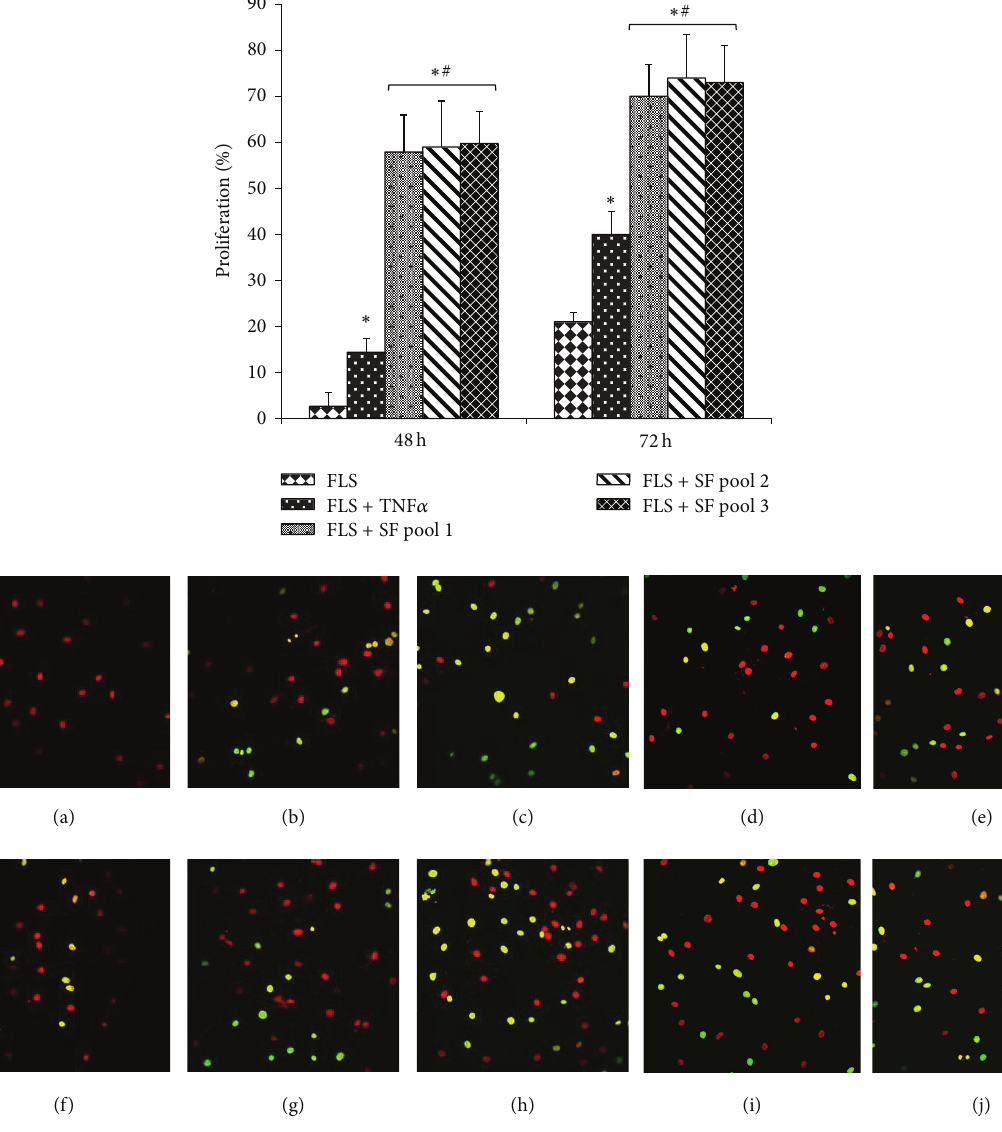
Figure 1: RA fibroblast-like synovial cells proliferation in the presence of synovial fluid or TNF 𝛼 . FLS were cultured in the presence of TNF 𝛼 (25 ng/mL) or three SF pools (1:8 dilution in culture medium). The DNA synthesis was evaluated after 24 h incubation with 10 𝜇 M 5-ethynyl- 2 󸀠 -deoxyuridine (EdU). Cells were then fixed and permeabilized, and EdU incorporated into newly synthesized DNA was detected using the fluorescent Alexa Fluor 488 azide. Analysis was performed using a confocal microscope. Data were obtained from triplicate experiments. Resultsareshownas%ofproliferation:%=(nucleistainedwithEdu/totalnuclei) × 100andrepresentfourindependentexperiments.Confocal microscopy images of a representative experiment are shown: cells cultured for 48h in alone medium (a), TNF 𝛼 (b), or SF pools (c, d, e), cells cultured for 72 h in medium alone (f), TNF 𝛼 (g), or SF pools (h, i, j). Green staining: newly synthesized DNA, red staining: Hoechst staining of total DNA. ∗ 𝑃 < 0.05 versus FLS; # 𝑃 < 0.05 versus FLS + TNF 𝛼